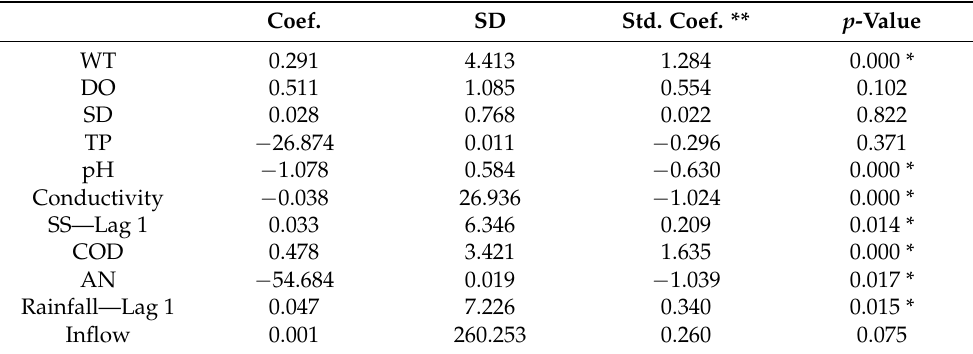
Table 8. Standardization coefficients of variables measured at the Shimen Reservoir. Coef. SD Std. Coef. ** p -Value WT